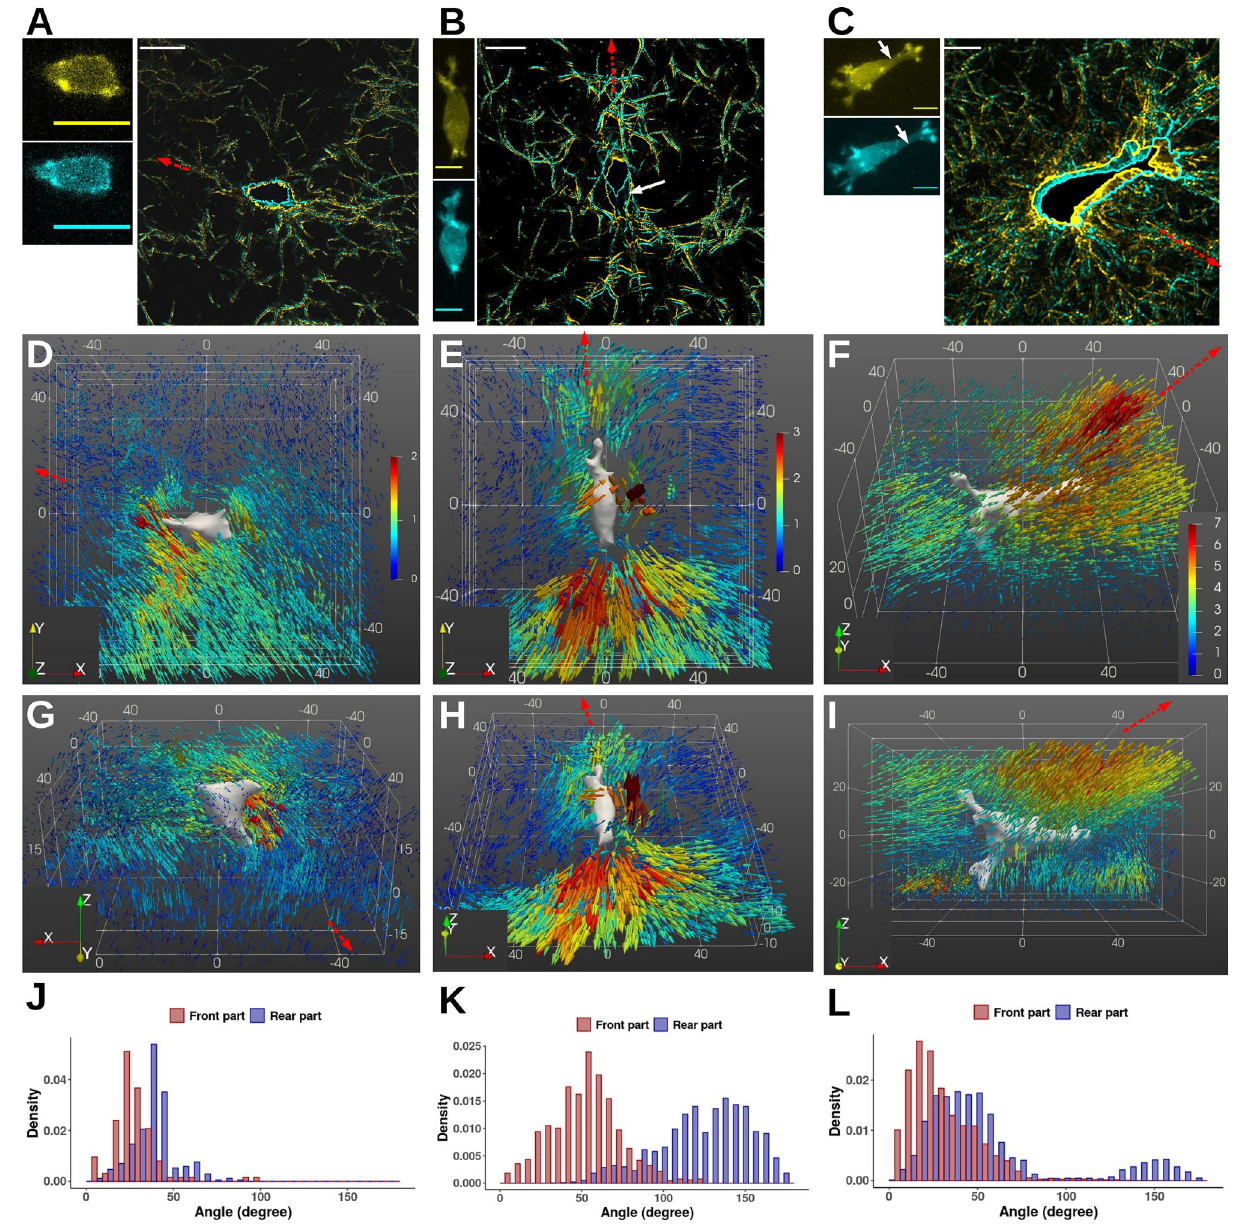
Figure 3. Boxes ( A – C ): Z-projections (left panels) of confocal fluorescence images of the actin cytoskeleton for three migrating bladder cancer cells (RT112, T24 and J82 respectively) embedded in a 0.95 mg/mL collagen gel, at 10 min time interval (first position in yellow, second one in cyan). Superposition of collagen fiber images (right panels) at these times, for one slice level in the image stack, with indication of cell contours. Scale bar = 20 μm. The white arrow indicates the rear of the T24 cell ( B ) or the long cylindrical protrusion displayed by the J82 cell ( C ). The red dotted arrow indicates the migration direction. Boxes ( D – I ): Corresponding 3D collagen fiber displacements around each migrating bladder cancer cells: RT112 ( D , G ), T24 ( E , H ), J82 ( F , I ). Two viewing angles have been selected. The initial 3D cell shape is shown in grey levels. The vector length and color indicate the displacement magnitude in μm. The x, y and z grids are in μm. The red dotted arrow indicates the migration direction. ( J – L ) Angle distributions of displacement vectors—with respect to the direction of migration—shown in red (resp. blue) for vectors located at the front (resp. at the rear) surface. The magnitude of the fiber displacements reaches important values (up to 7.1 μm) with vectors showing [0°–80°] orientation at the front and [0°–180°] at the rear (see Fig. 3L). The largest displacements (magnitude > 5 μm) are observed at the front along the migration axis and also at the rear with a mean orientation around 150° (see Fig. 3F,I). At the rear part, some displacements are also visible at long distances with a mean orienta- tion around 50°. Cell dynamics and collagen displacements can be summarized as follows: